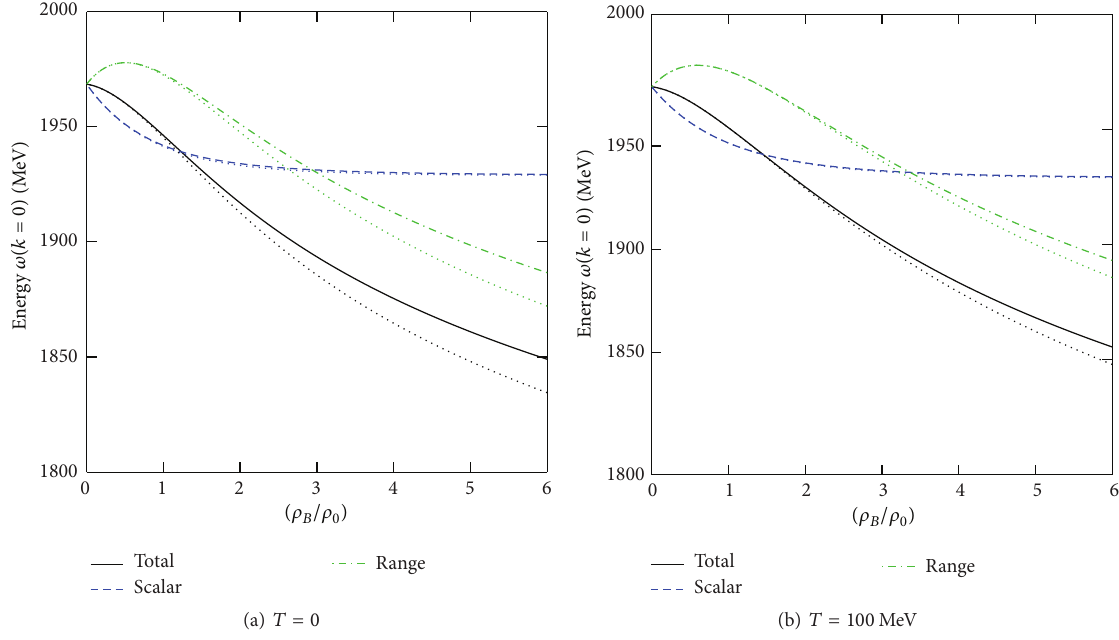
⃗𝑘 = 0) Figure 1: The various contributions to the 𝐷 𝑆 meson energies, 𝜔( , in nuclear matter, plotted as functions of baryonic density in units of the nuclear saturation density ( 𝜌 𝐵 /𝜌 0 ). In each case, the isospin asymmetric situation ( 𝜂 = 0.5 ), as described in the legend, is also compared against the symmetric situation ( 𝜂 = 0 ), represented by dotted